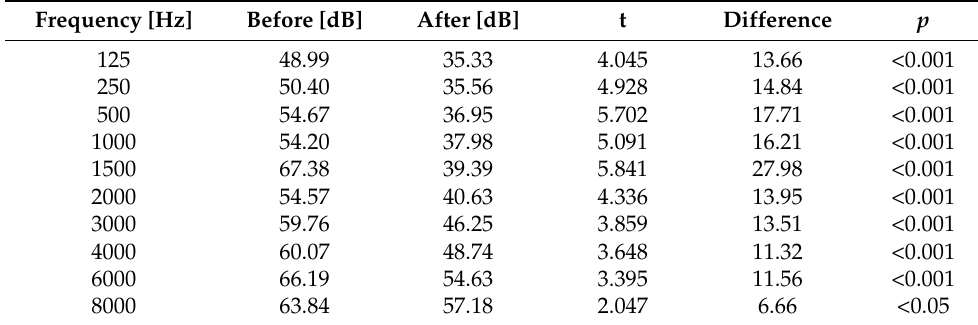
Table 1. Characteristics of hypoacusis—AC.